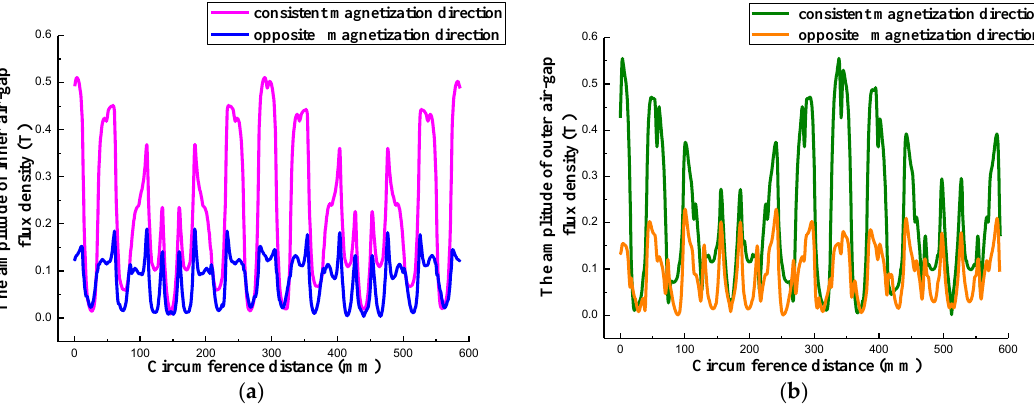
Figure 9. The diagram of the magnetic flux flow in the CSPM motor: ( a ) consistent magnetization direction of the permanent-magnet; ( b ) opposite magnetization direction of the permanent-magnet.